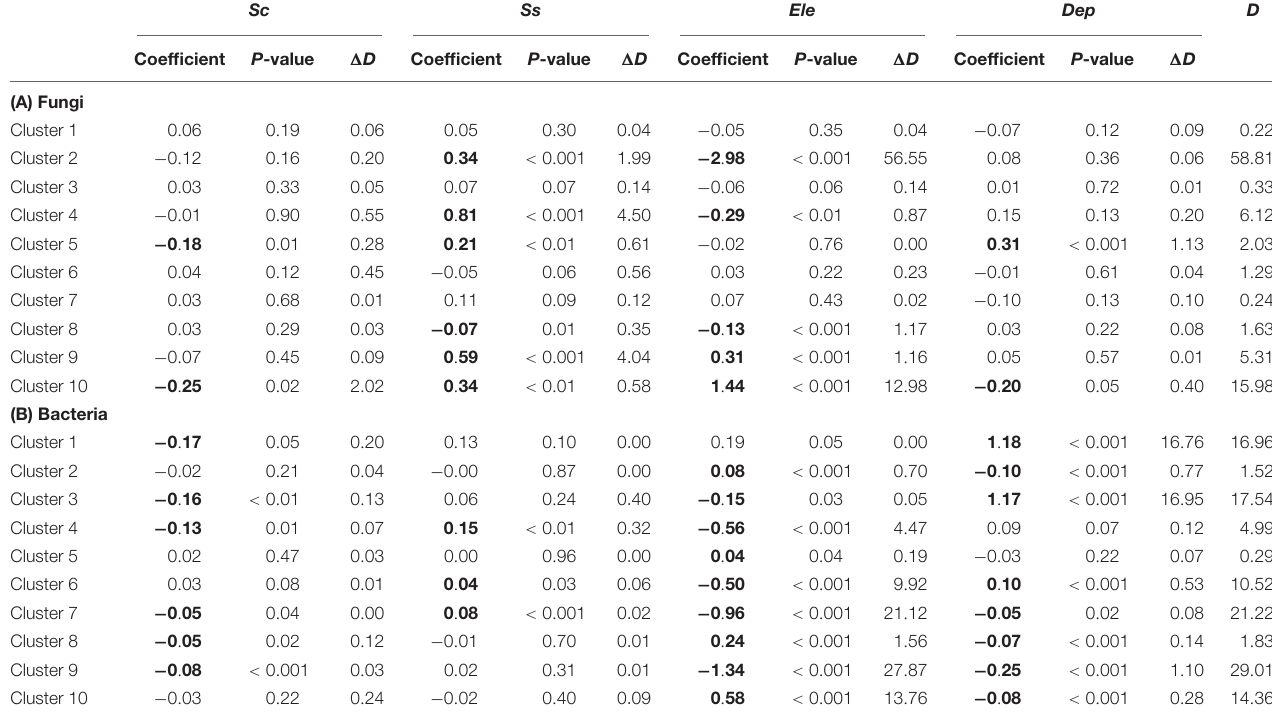
TABLE 2 | Results of finite mixtures of negative binomial regression models. Sc Ss Ele